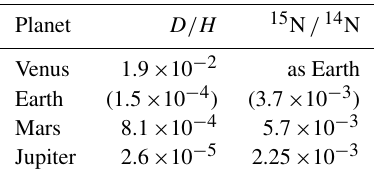
Table 5. Planetary isotopic ratios as applied in the isotopologue abundance data table generation. Values for Venus, Earth, and Mars taken from Lammer et al. (2008, Table 1); those for Jupiter are taken from Owen and Encrenaz (2003). The Earth values are given for ref- erence only because in the actual table generation we inferred them from the HITRAN Earth Isotopologue abundance for each individ- ual molecule. Planet D/H 15 N / 14 N Venus 1.9 × 10 − 2 as Earth Earth (1.5 × 10 − 4 ) (3.7 × 10 − 3 )